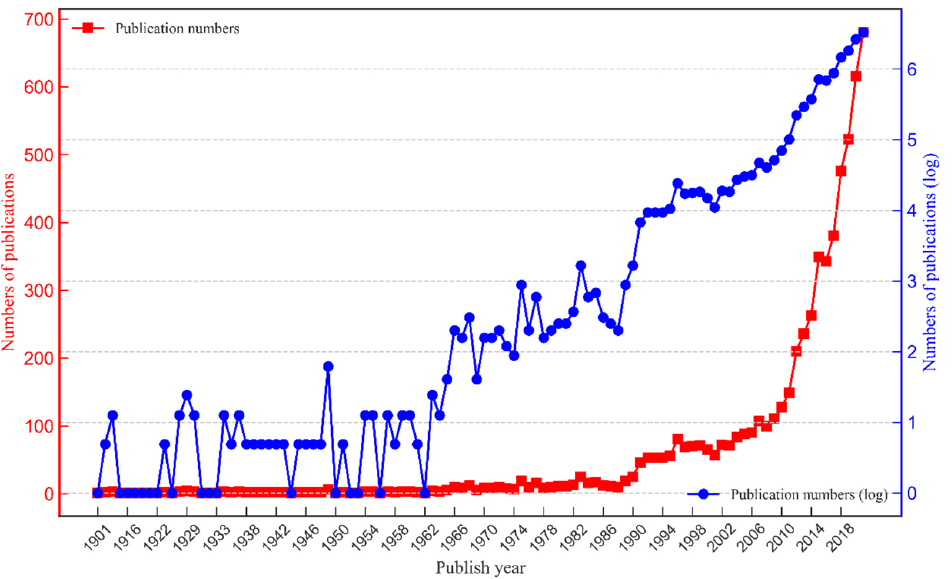
Figure 2. Timeseries variations of publication outputs and logarithmic value changes in oil and gas well research in the WOS core collection database, 1900–2021.